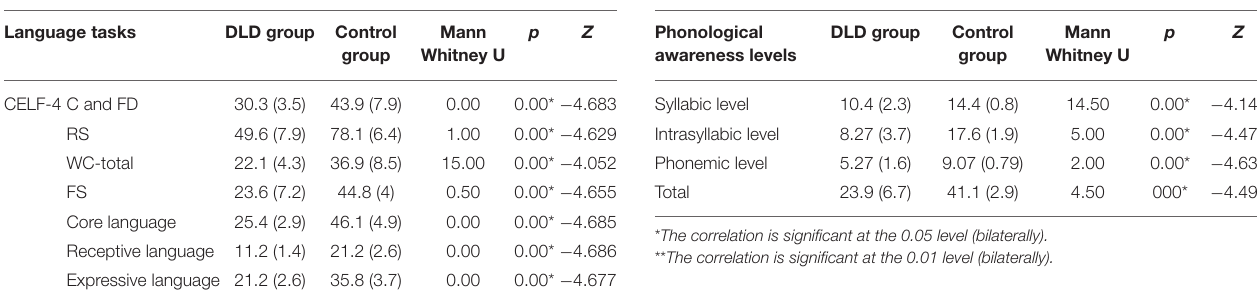
TABLE 2 | Language tests results. TABLE 3 | Phonological awareness